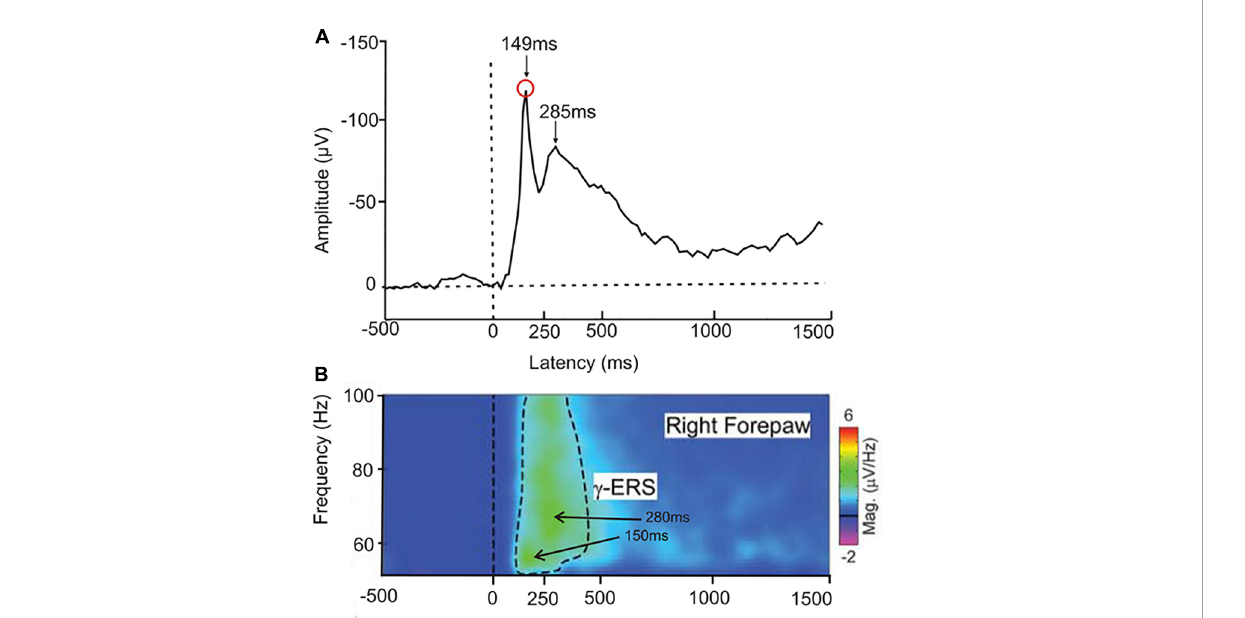
FIGURE4 Responses of freely moving rats to a heat stimulus applied to one of the paws. (A) Averaged ERP (4 central electrodes on the rat head, 12 animals in the experimental group) in response to a heat stimulus to the right forepaw. Two negativity peaks are visible, one at about 149 ms latency after heat onset, the other at about 285 ms latency. (Modified from Peng et al., 2018; their Supplementary Figure 3). (B) EEG group response to a single heat stimulus averaged to display the gamma-band event-related synchronization ( γ -ERS) for frequencies of 50–100 Hz. There are two intensity peaks of the gamma-waves, one at about 55 Hz with a 150 ms latency after heat onset, the other at about 65 Hz with a 280 ms latency. The latencies of these peaks in the gamma-band activity correspond closely to the ERP peaks shown in (A) . [Modified from Peng et al. (2018); their Figure 2].